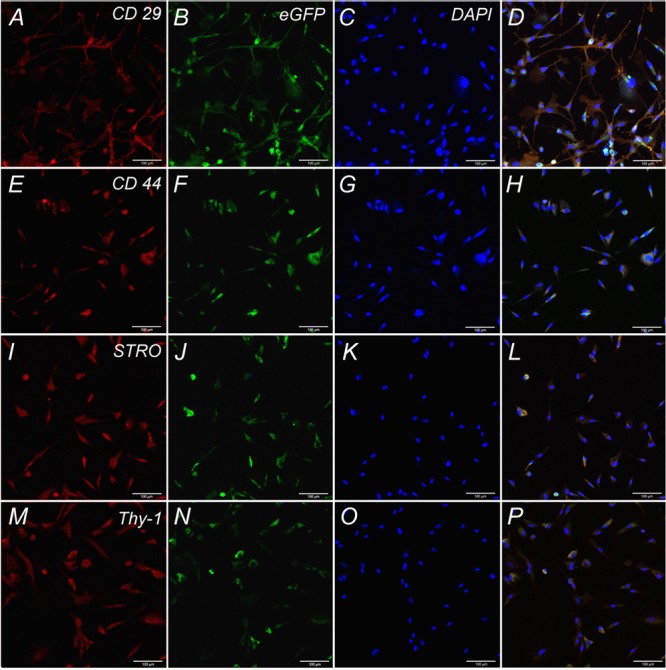
Expression of CD 29, CD 44, STRO, Thy-1 by undifferentiated ADSCs subpopulations. Row 1: Confocal analysis of the expression of CD 29 (A), e-GFP (B), DAPI (C), Merge (D). Row 2: Confocal analysis of the expression of CD 44 (E), e-GFP (F), DAPI (G), Merge (H). Row 3: Confocal analysis of the expression of STRO (I), e-GFP (J), DAPI (K), Merge (L). Row 4: Confocal analysis of the expression of Thy-1 (M), e-GFP (N), DAPI (O), Merge (P). Bar: 100 μm.